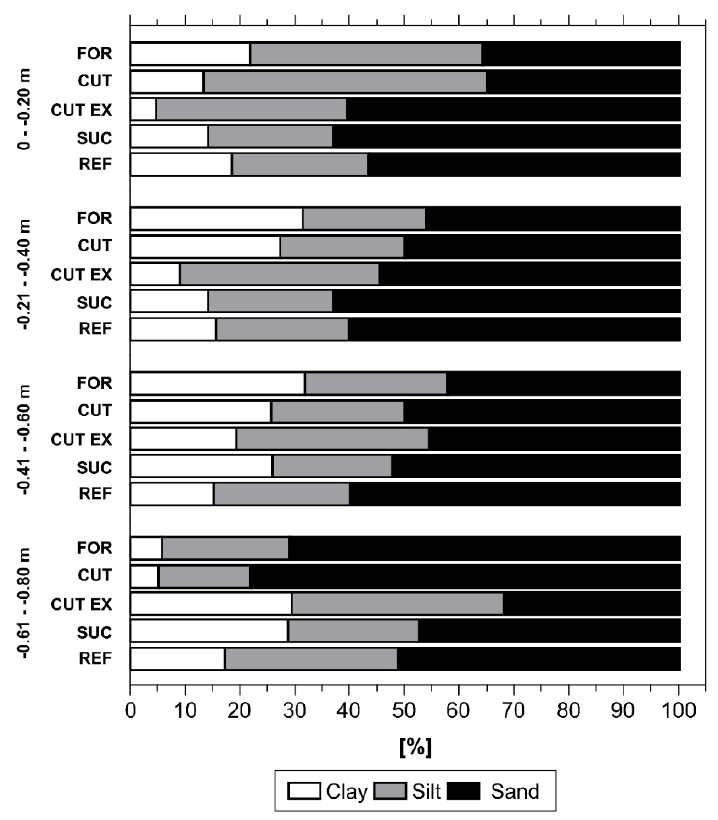
Figure 5. Mean percentages of clay, silt and sand of each area and depth-category. Both FOR and CUT show a similar pattern of clay-, silt- and sand-content, with dominant silt- percentages in the upper 0.2 m, indicating a well-developed A-Horizon. In all other depths, sand is the dominant grain size, with rapidly increasing percentages between −0.61 and −0.8 m, indicating